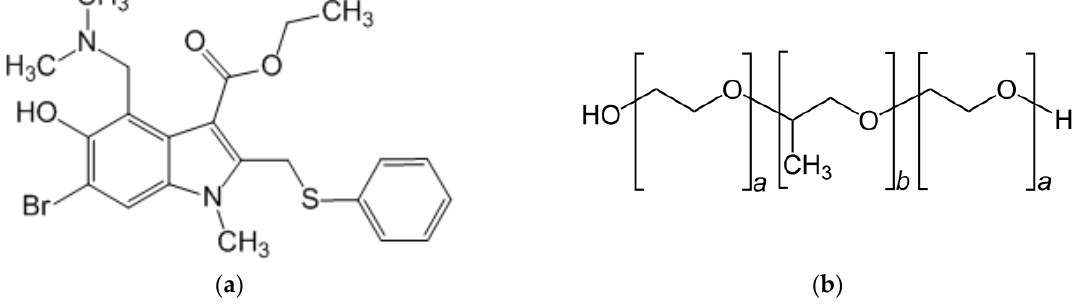
Figure 1. Umifenovir (UMF) ( a ) and pluronic F-127 ( b ) structures.